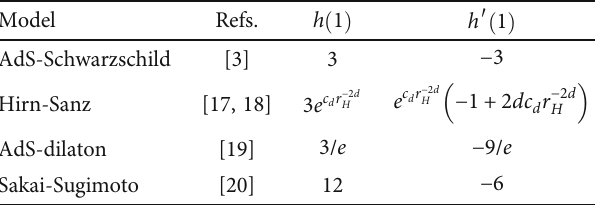
Table 2: Parametric dependence of h ð 1 Þ and h ′ ð 1 Þ for the non-AdS cases in Equation (10). Model